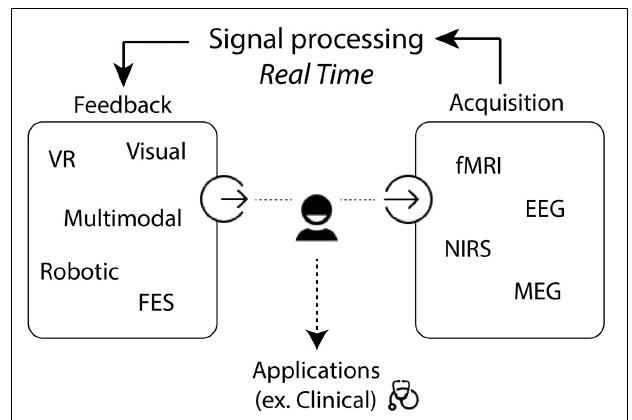
FIGURE 1 | Description of the Neurofeedback loop. NFB, neurofeedback; EEG, electroencephalography; fMRI, functional magnetic resonance imaging; NIRS, near infrared spectroscopy; MEG,